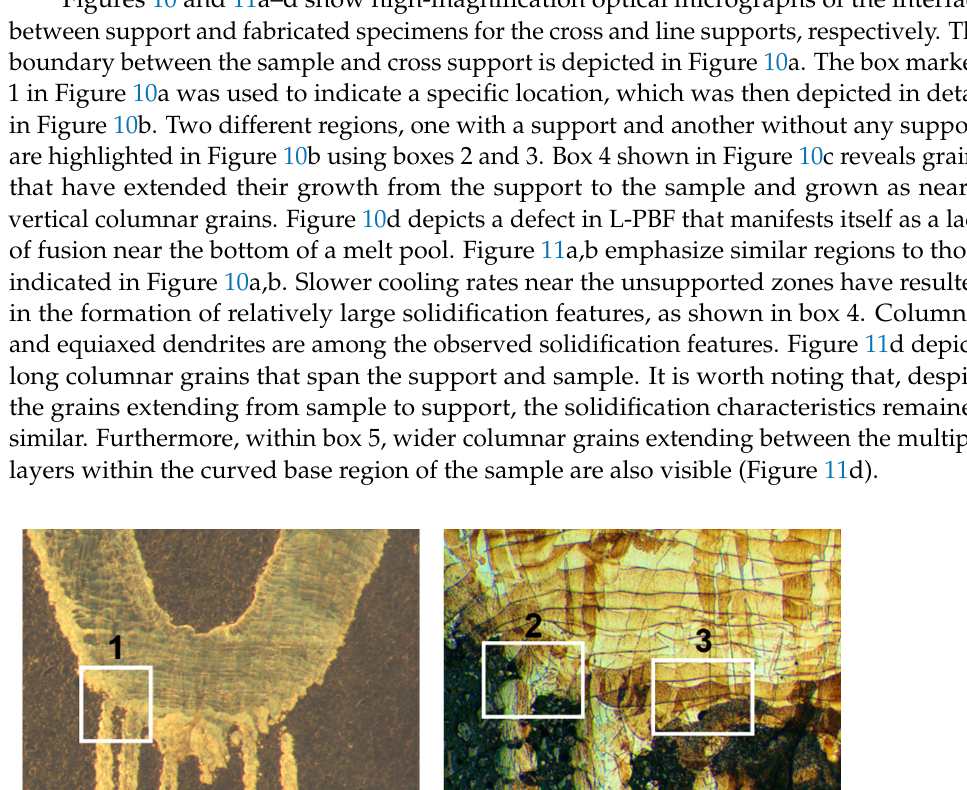
Figure 11. Light microscopy images taken at different magnifications representing the boundary between support and specimen for ( a ) line support with ( b ) two regions highlighted, and these are shown in detail in ( c , d ) . 3.2. Support Removal Strategies The removal of undesired materials (in this case, support structures) is a crucial step in achieving the final shape of the component using L-PBF. Due to the complex geometry of aortic stents, automated machining systems may not be able to reach the vicinity of the